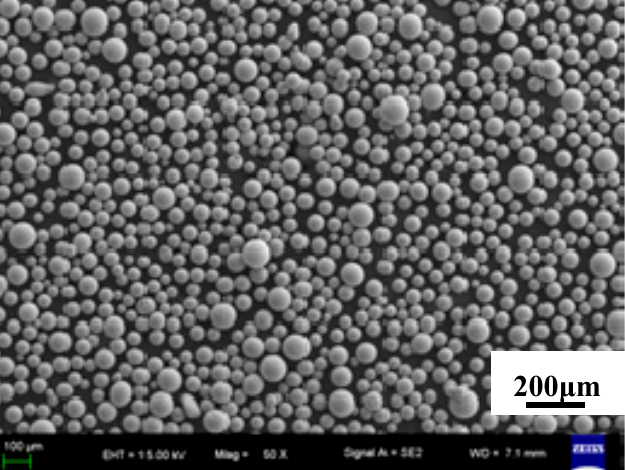
Figure 1. SEM photos of TC4 powder (500 × ). Table 2. Chemical composition of as-built TC4 material.